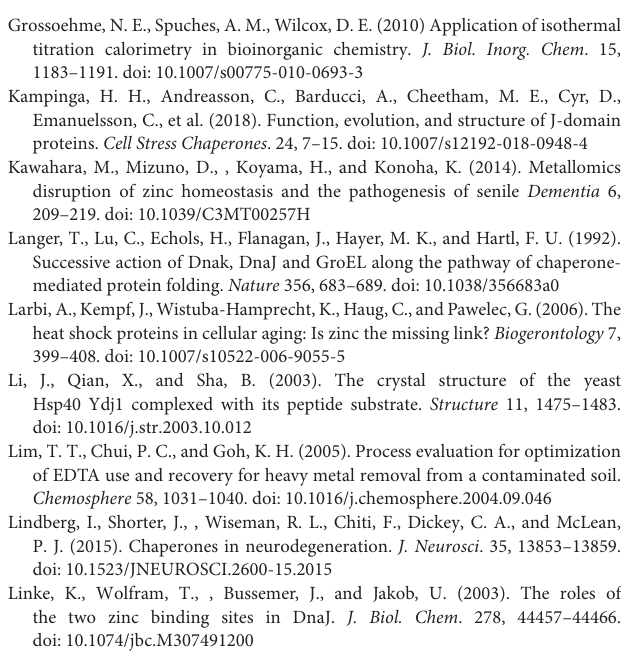
Figure S2 | Interaction between Ydj1 and Zn verified by ITC. Thermodynamic parameters were derived from non-linear least-squares fitting implemented by the Origin software. ITC experiment consisted of 3 µ l injections of either 2 (left) or 4 (right) mM ZnCl 2 to 30 µ M Ydj1 (monomer concentration) with an interval of 300s between injections. Solutions of titrants and titrates were made from the same buffer [25 mmol L − 1 Tris-HCl buffer (pH 7.5) and 500 mmol L − 1 NaCl] and thoroughly degassed prior to